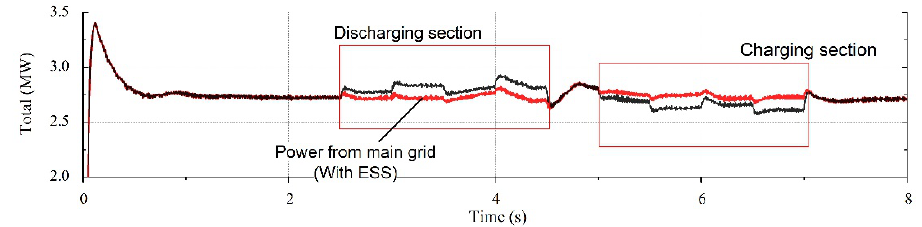
Figure 7. Power supply quantity from main grid in designed scenario (with and without ESS).